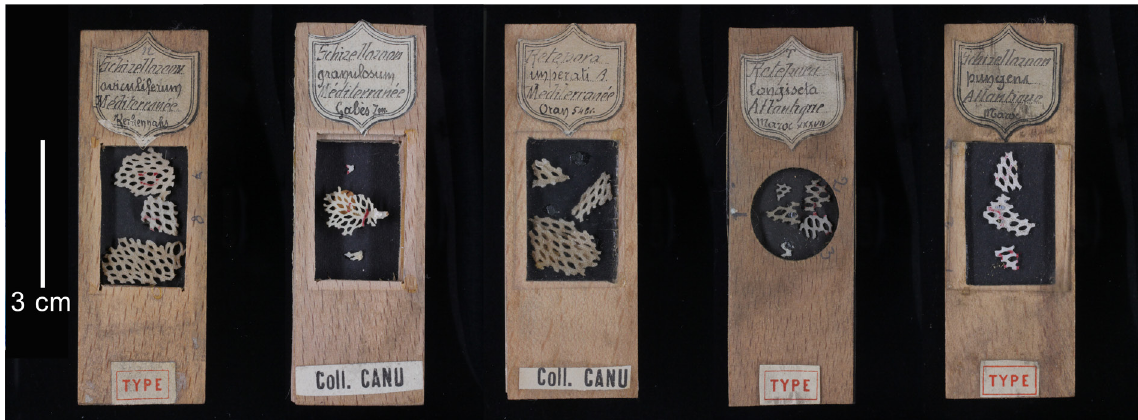
Fig. 1. Preparations of the ‘ imperati -group’: Schizoretepora aviculifera (Canu & Bassler, 1930) (MNHN-IB-2014-24), S. granulosa (Canu & Bassler, 1930) (MNHN-IB-2014-21), S. imperati (Busk, 1884) (MNHN-IB-2014-29), S. longisetae (Canu & Bassler, 1928) (MNHN-IB-2014-19) and S. pungens (Canu & Bassler, 1925) (MNHN-IB-2014-20) . Specimens located at the Departments of Zoology and Paleontology of the MNHN in